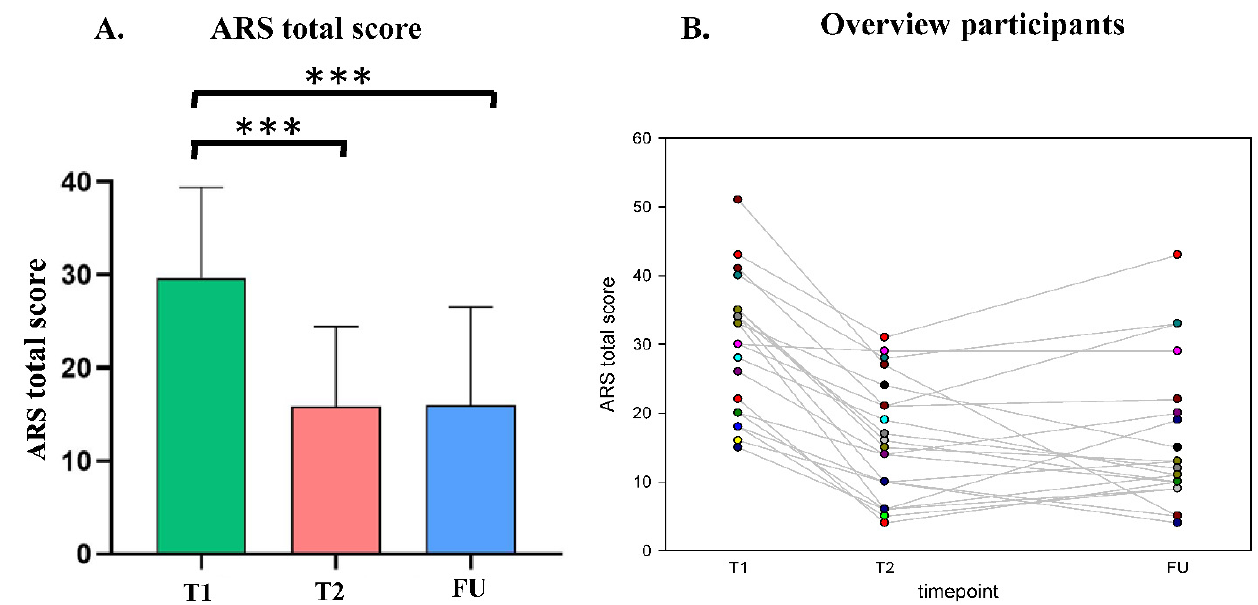
Figure 2. ( A ) Means and standard deviations of the ARS total score. T1 = start of the oligoantigenic diet, T2 = end of the oligoantigenic diet, FU = follow-up (*** p < 0.001) ( B ) ADHD rating scale for all the participants who attended the follow-up ( n = 21), T1= start of the oligoantigenic diet, T2 = end of the oligoantigenic diet, FU = follow-up. (Each patient appears in different color). Table 4. Means, standard deviations, repeated-measures analyses of variance, and post hoc com- parisons with effect sizes for the scales of the primary outcome measure ADHD Rating Scale ( n = 21).